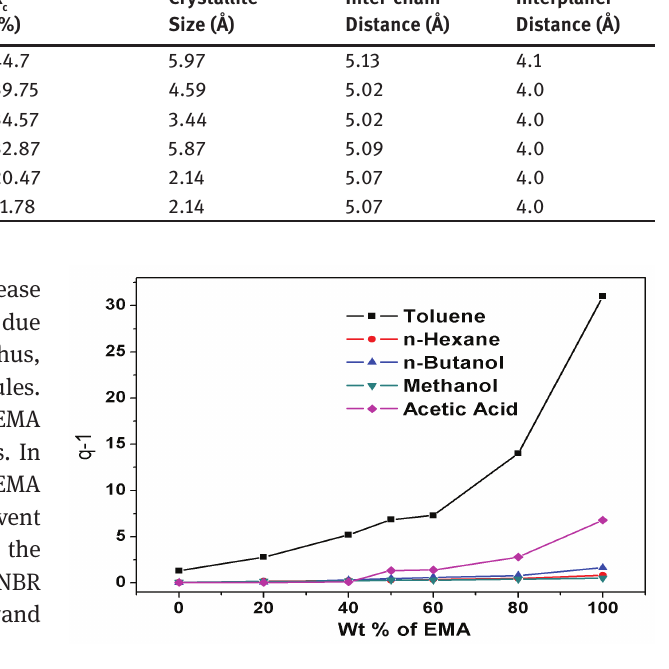
Table 5: XRD results of pristine polymers and their blends. Sample ID